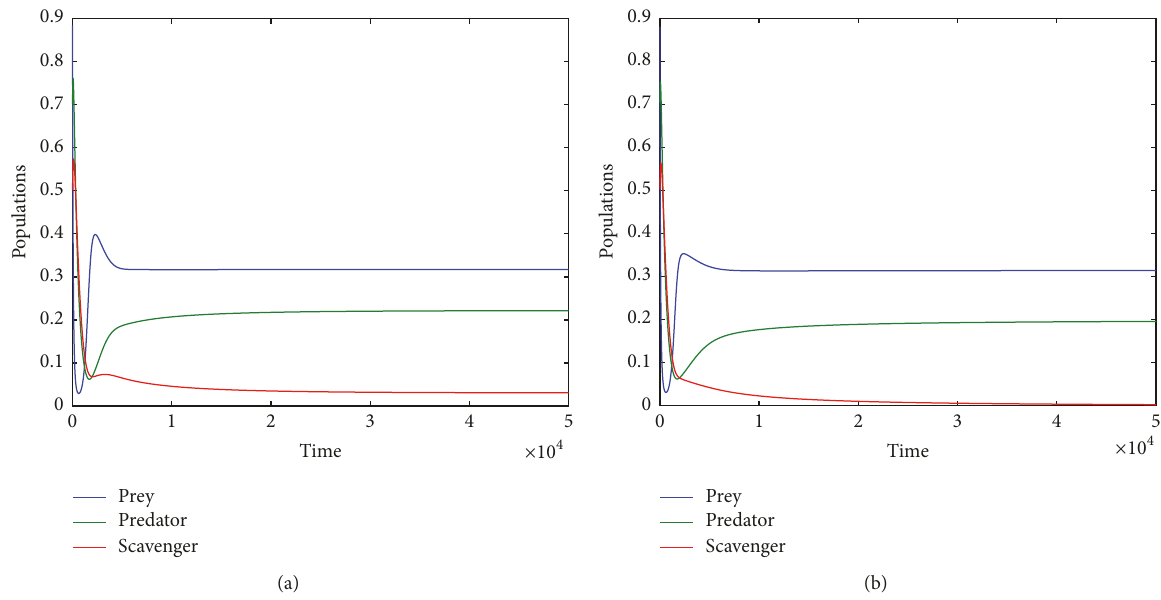
Figure 9: Time series for the solution of system (3) using data (76) with varying some parameters. (a) The system approaches positive equilibrium point 𝐸 4 = (0.31,0.22,0.03) for 𝛼 = 0.4 , 𝛽 = 0.3 . (b) The system approaches scavenger free equilibrium point 𝐸 2 = (0.31,0.19,0) for = 0.4, 𝛽 = 0.9 .